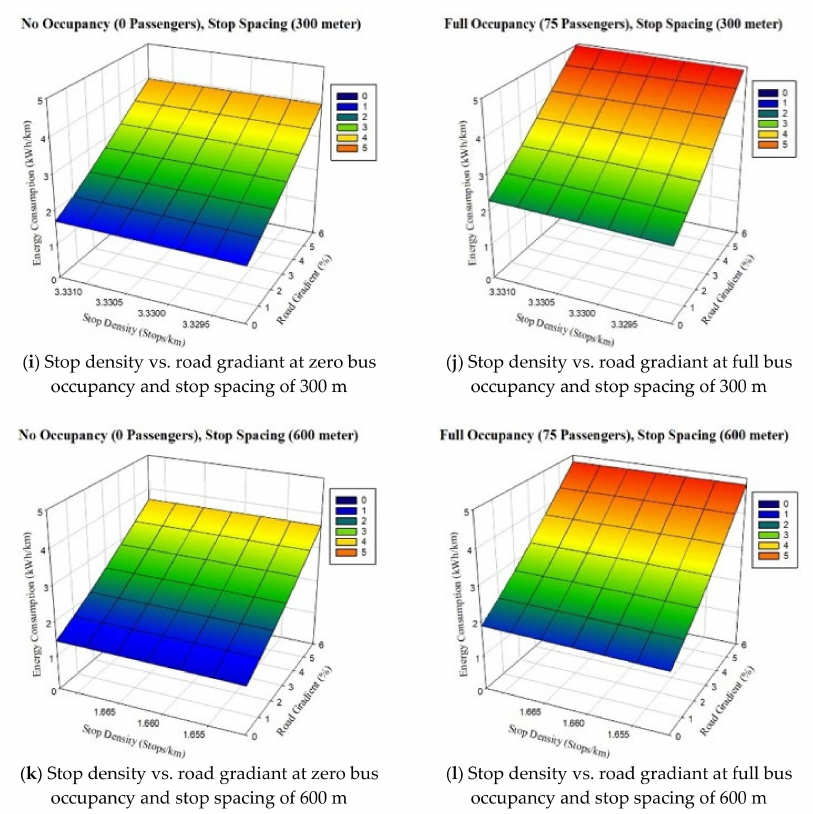
Figure 9. 3D plots for the relationships between EC and the independent